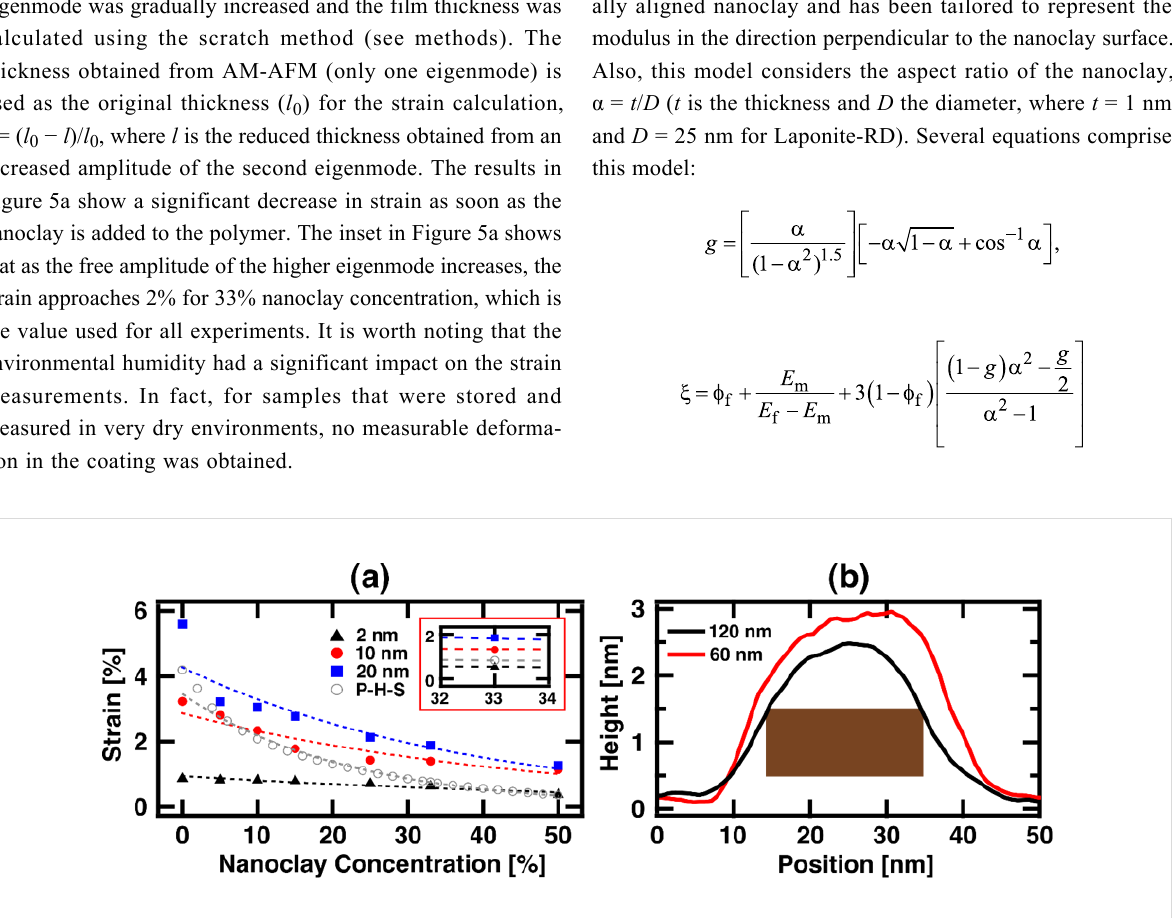
Figure 5: (a) Strain (vertical axis) produced by bimodal AFM in the nanocomposite film for different Laponite-RD nanoclay concentrations by weight (horizontal axis), using different values of the higher eigenmode free oscillation amplitude, indicated by the red, black and blue markers. The grey markers show the calculated strain using a combination of the modified Pukánszky and Hui–Shia model (P-H-S) [65,66]. All the results are fitted to exponential functions, shown in dashed lines. (b) Measurement of an individual Laponite-RD nanoclay platelet after polymer adsorption onto the sur-